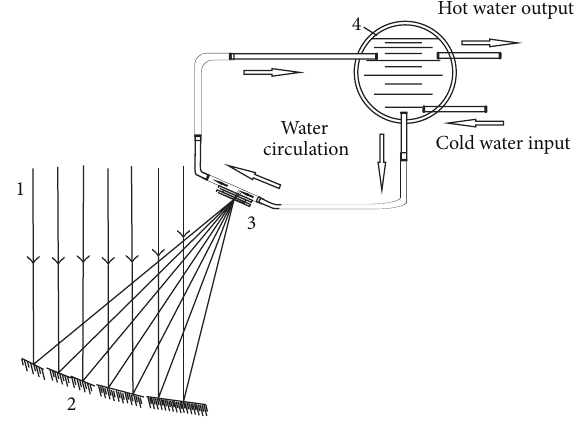
Figure 1: A schematic of the hybrid system.